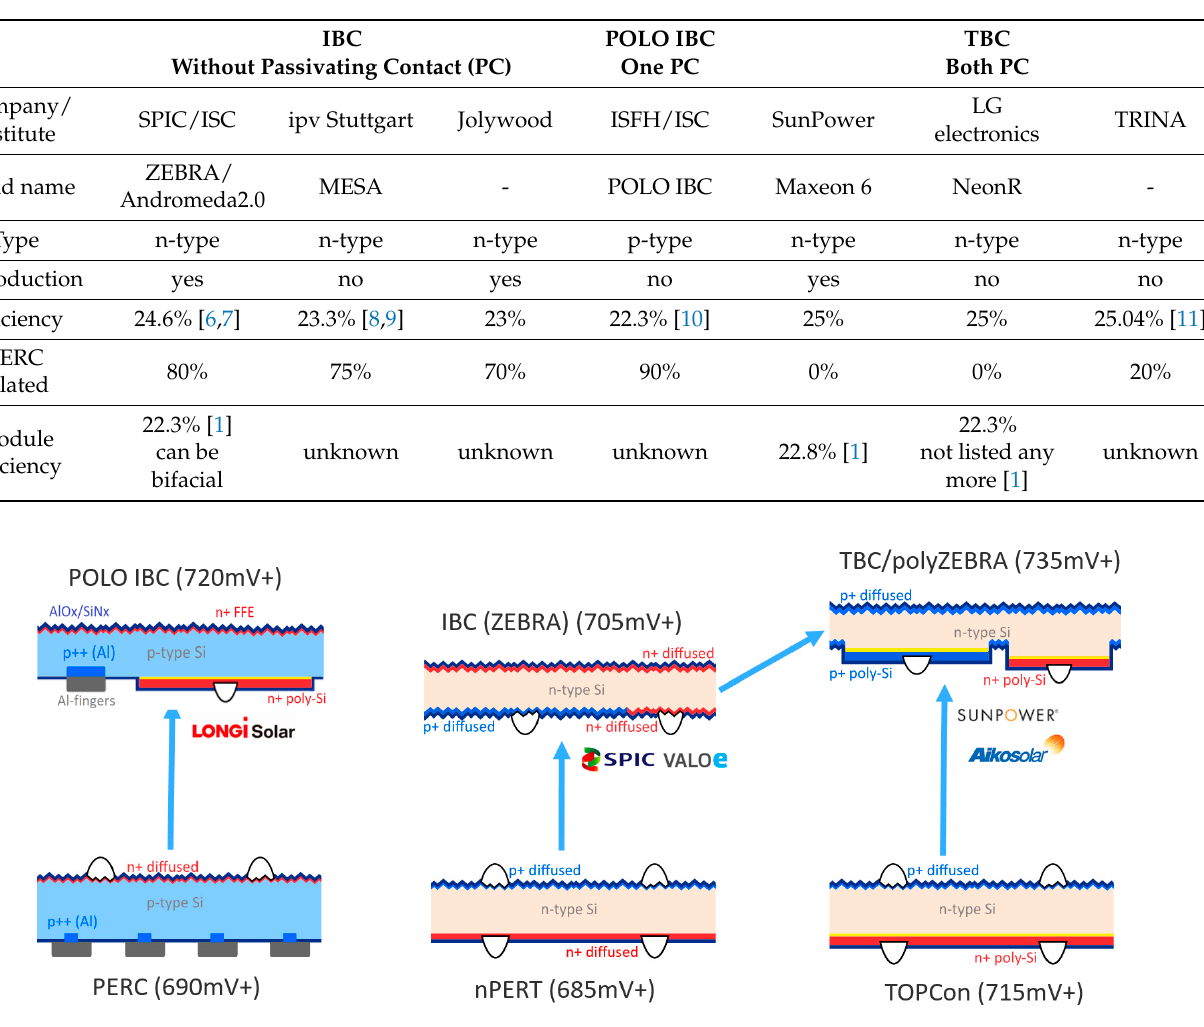
Figure 3. Different structures of IBC solar cells as evolutions from different both-sided contacted solar cells.